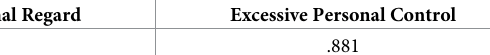
Table 2–5. The reliability of Controlling Coach Behaviors Scale. Total α